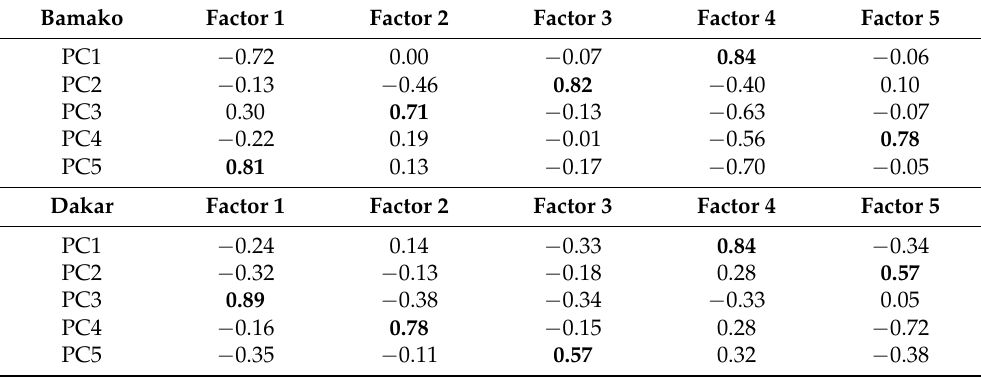
Table 4. Pearson correlations between PCA principal components (PCs) and PMF model sources (Factors). The significant positive correlations are highlighted in bold. p values ≤ 0.05 were used to determine significance. Bamako Factor